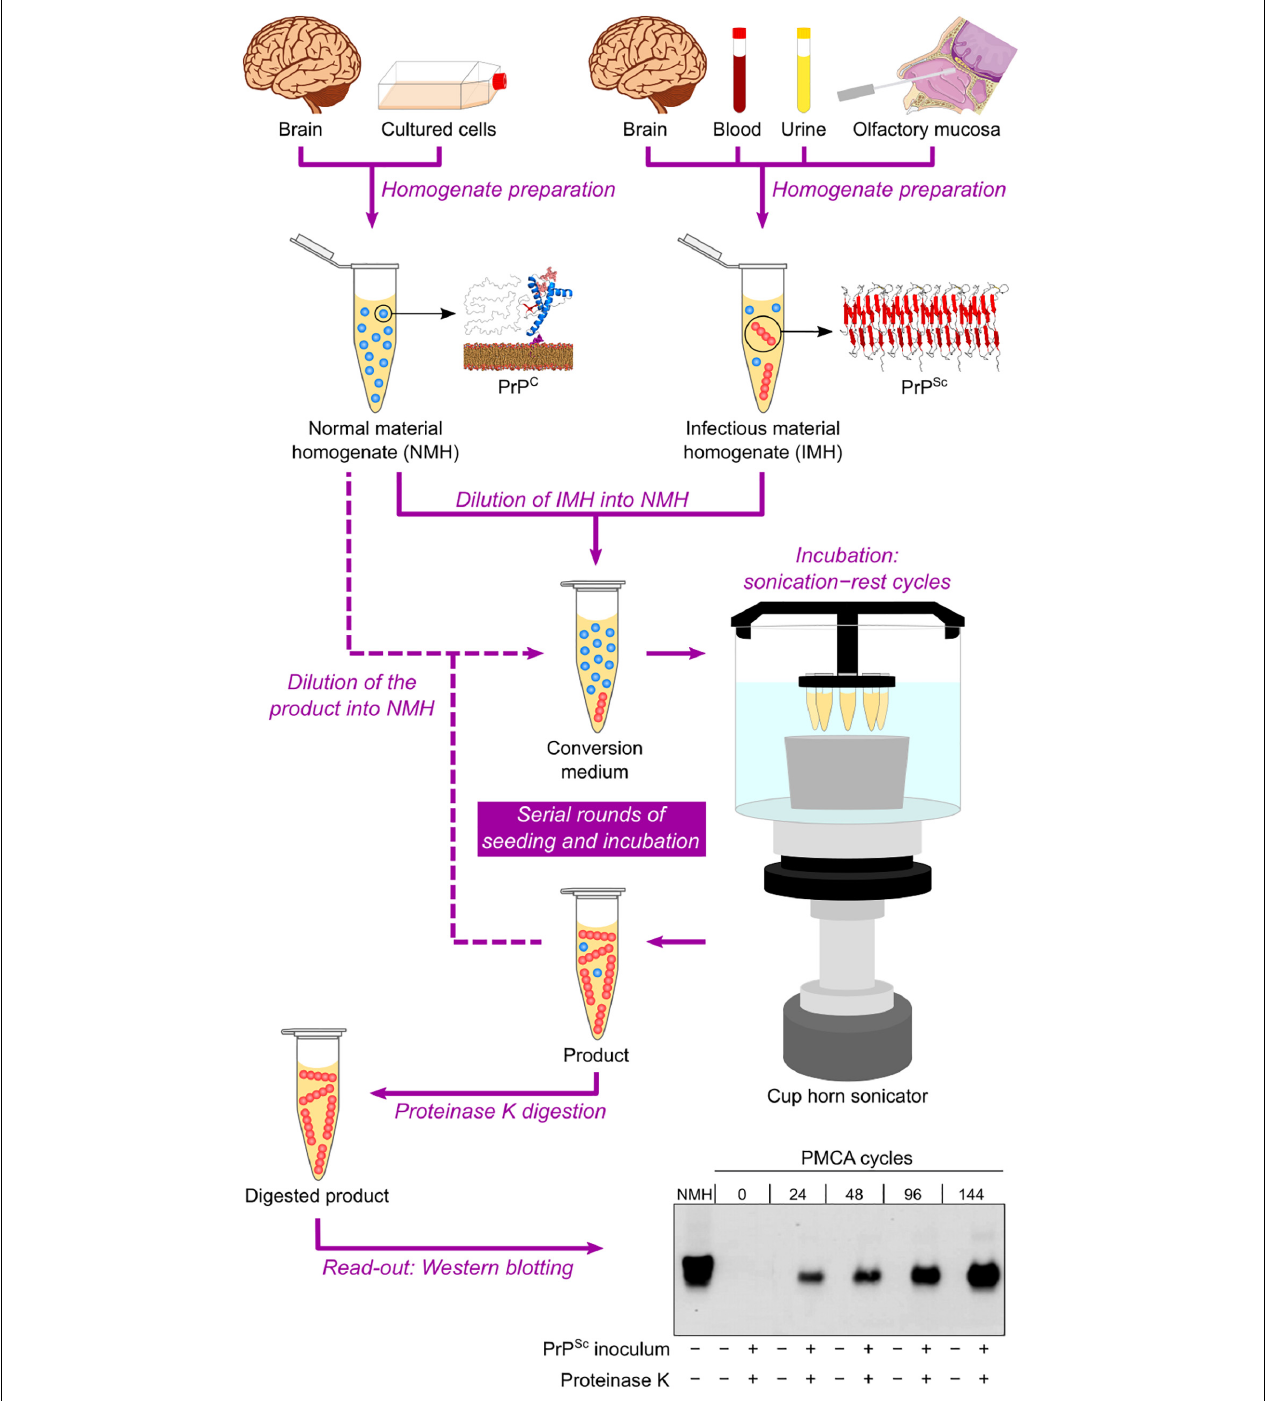
FIGURE 3 | Protein misfolding cyclic amplification (PMCA) in automated fashion. Normal material homogenate (NMH), a source of PrP C (substrate), is prepared from brain sections or cultured cells. Suspected infectious material homogenate (IMH), a possible source of PrP Sc (seed), is prepared from brain sections, blood, urine, or olfactory mucosa brushings. Suspected IMH is diluted into NMH, and the resulting mixture is incubated with alternating cycles of sonication and rest. Subsequent rounds can be performed by diluting the product of the previous round into fresh NMH and repeating the incubation step. As a result, the amount of PrP Sc is amplified after several sonication–rest cycles and even more after serial rounds of seeding and incubation. The products from different cycles and rounds are treated with proteinase K to eliminate PrP C and then subjected to Western blotting to reveal the growing amount of res PrP. This result indicates a positive TSE diagnosis. The Western blot shown is republished with permission of American Society for Biochemistry and Molecular Biology, from Ultra-efficient replication of infectious prions by automated protein misfolding cyclic amplification, Saá, Castilla, and Soto, 281, 46, 2006; permission conveyed through Copyright Clearance Center, Inc.